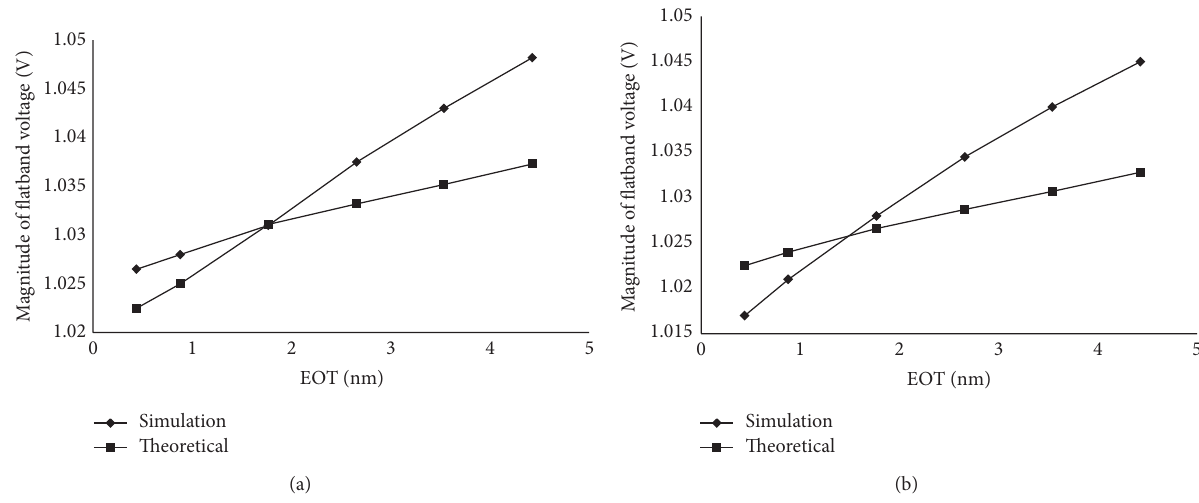
Figure 2: Variation of flatband voltage with oxide thickness for (a) ZrO 2 and (b) HfO 2 . Table 2: Interface charge 𝑄